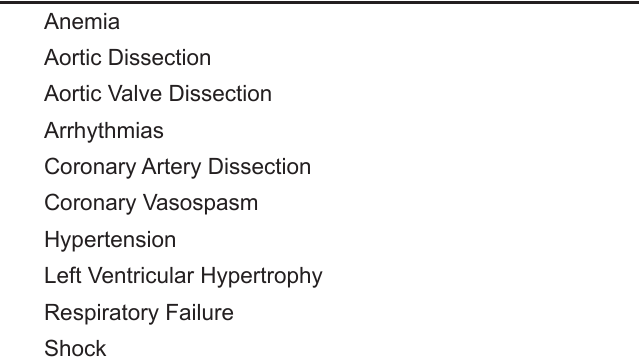
Table 2. Causes of type 2 myocardial